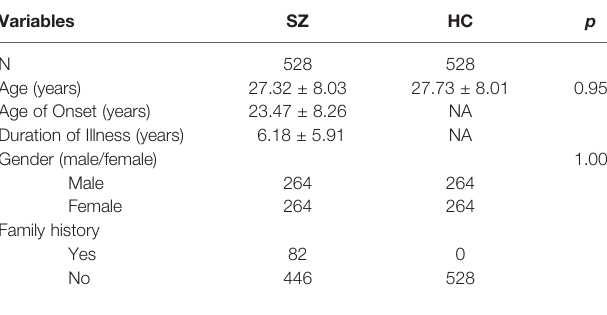
TABLE 1 | Demographics of the schizophrenia patients and healthy controls.